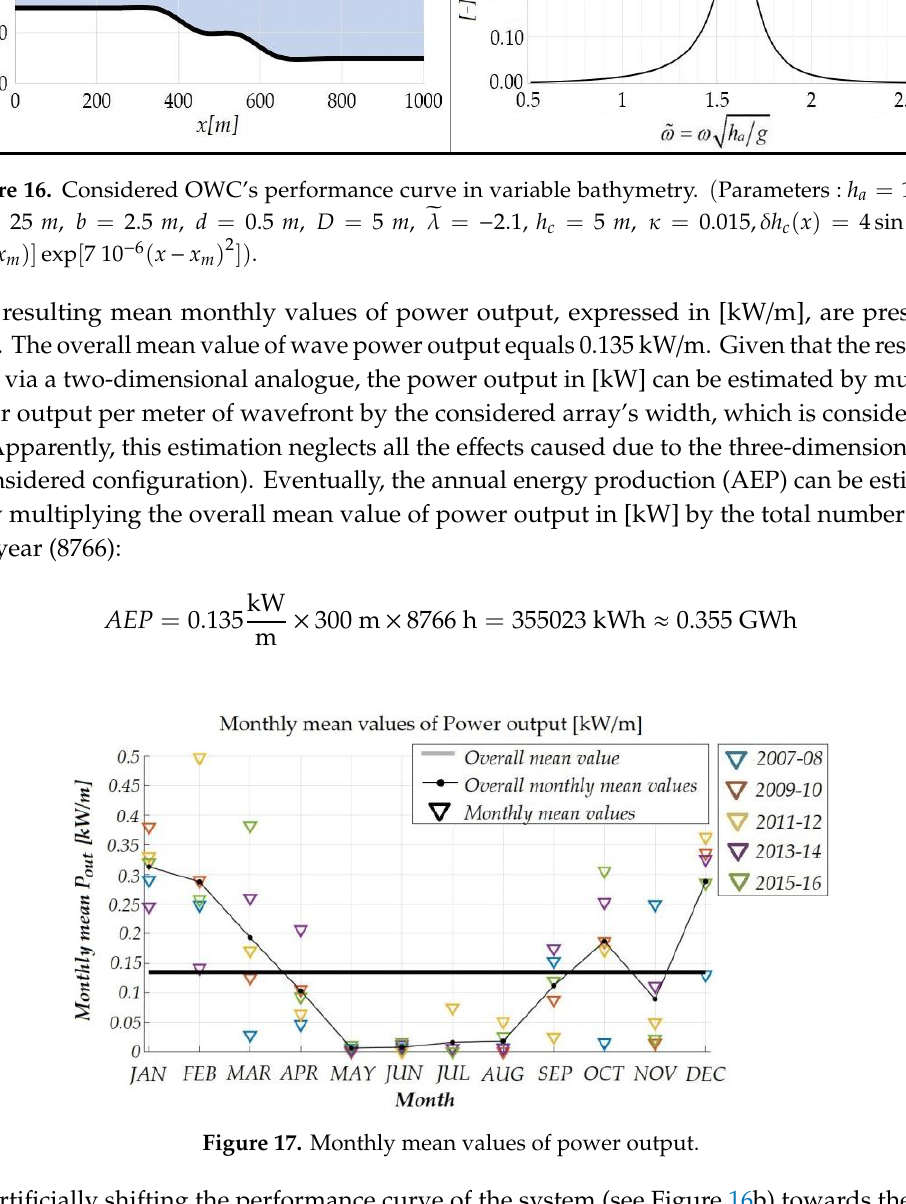
Considered OWC’s performance curve in variable bathymetry.